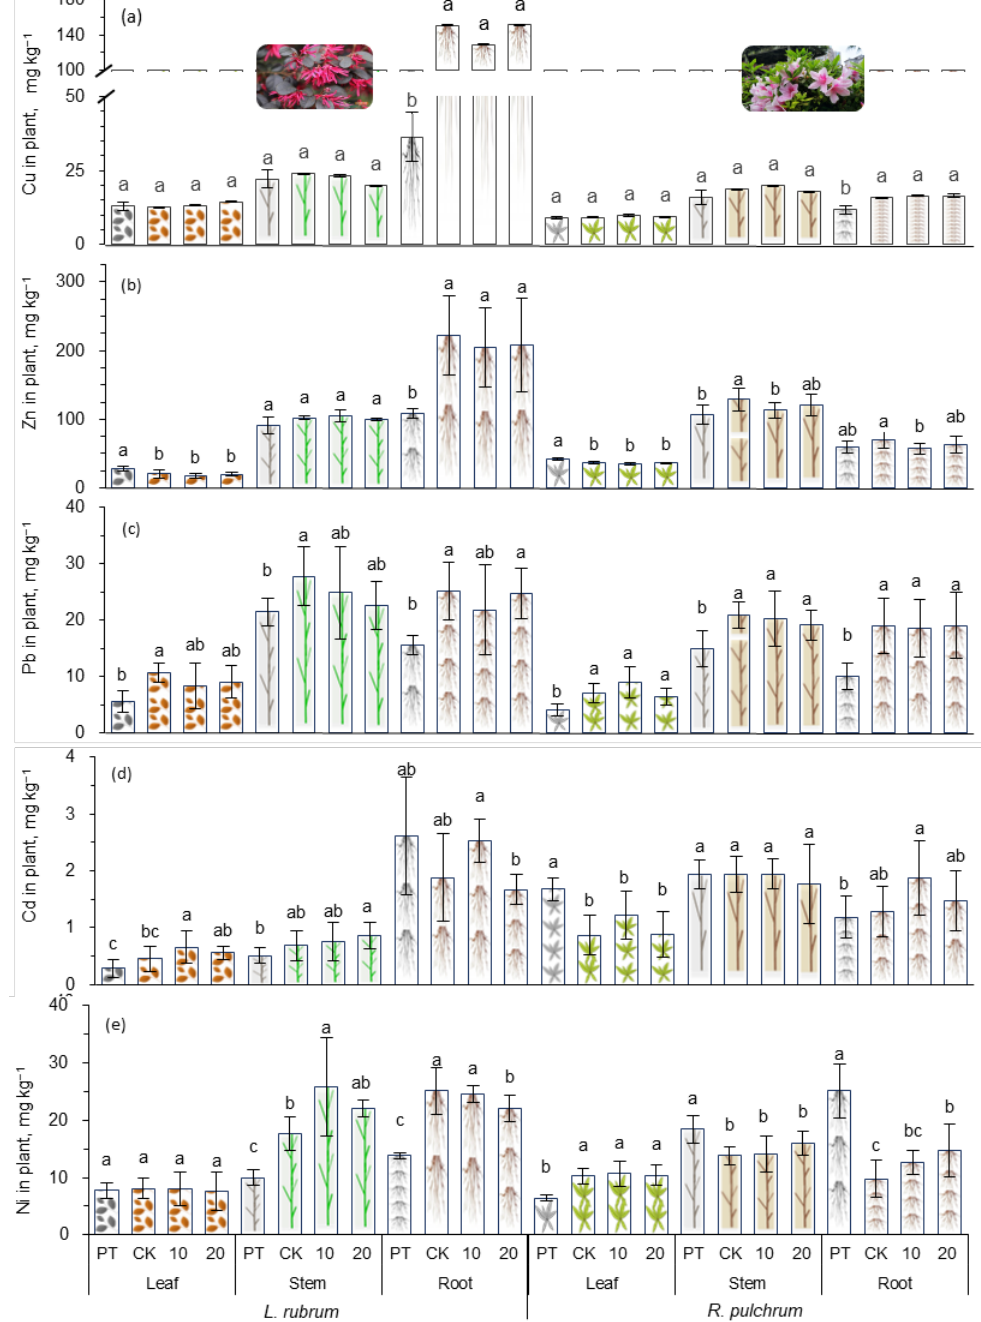
Figure 5. Heavy metal concentration in different parts of the ornamental plants under heavy metal stress and applying IAA. In the figure ( a ) – ( e ) are the effects of Cu, Zn, Pb, Cd and Ni on concentrations in different plant parts. Different letters indicate significant differences among the treatments, p < 0.05. The posthoc test was performed with Tamhane method. PT indicates samples of pre-treat- ment, while CK, 10, and 20 are IAA treatments at 0, 10, and 20 mg L −1 , respectively.